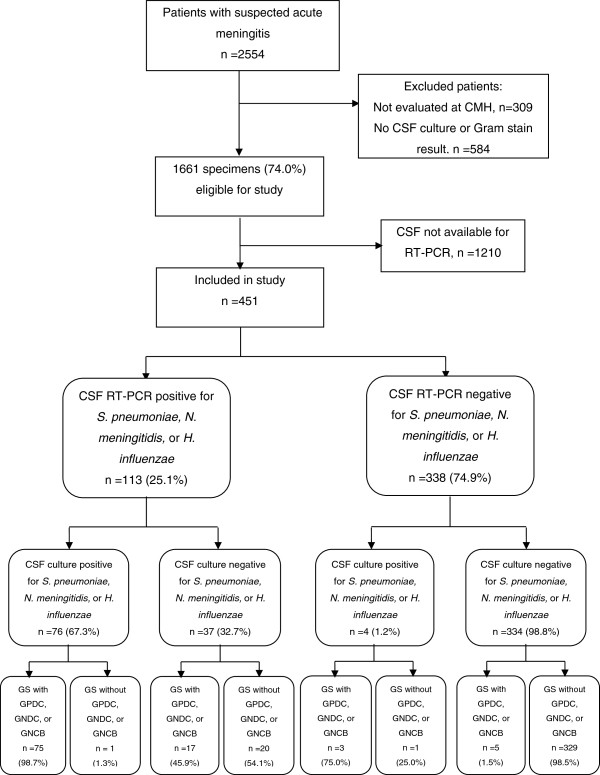
Participant inclusion, RT-PCR, and culture results flow diagram. Following exclusion of patients not meeting inclusion criteria and specimens that were unavailable for RT-PCR testing, the RT-PCR and culture results were analyzed for 451 specimens. Abbreviations: CMH, Couto Maia Hospital; CSF, cerebrospinal fluid; RT-PCR, real-time polymerase chain reaction; GS, Gram stain; GPDC, gram-positive diplococci; GNDC, gram-negative diplococci; GNCB, gram-negative pleomorphic coccobacilli.